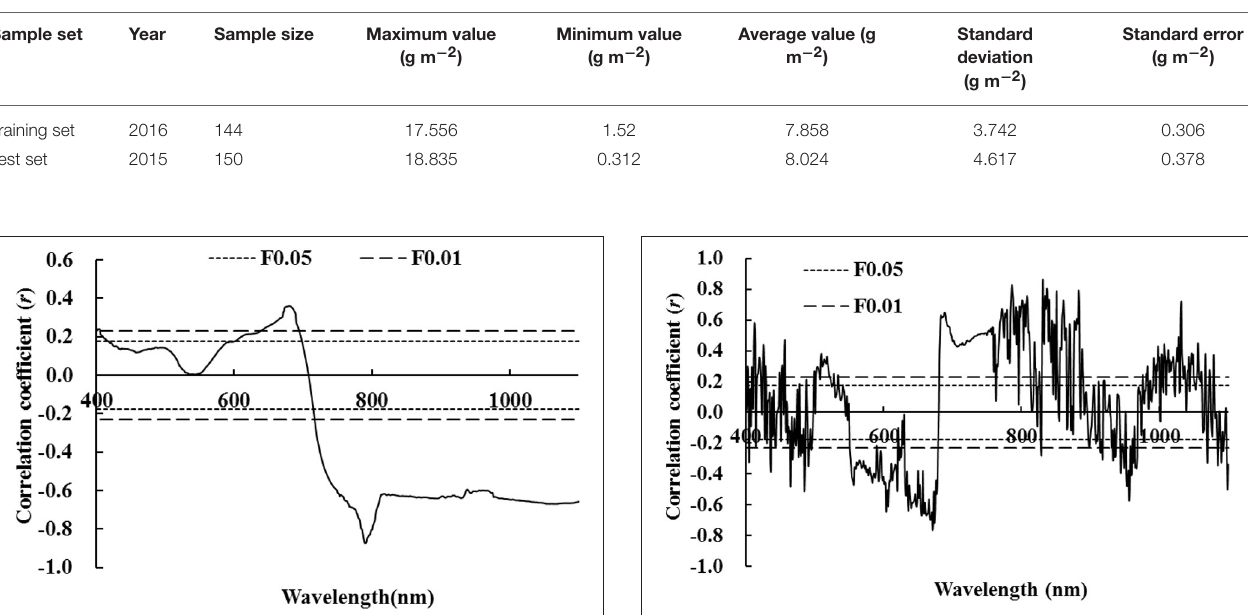
TABLE 2 | Distribution of LNA in training and test datasets.